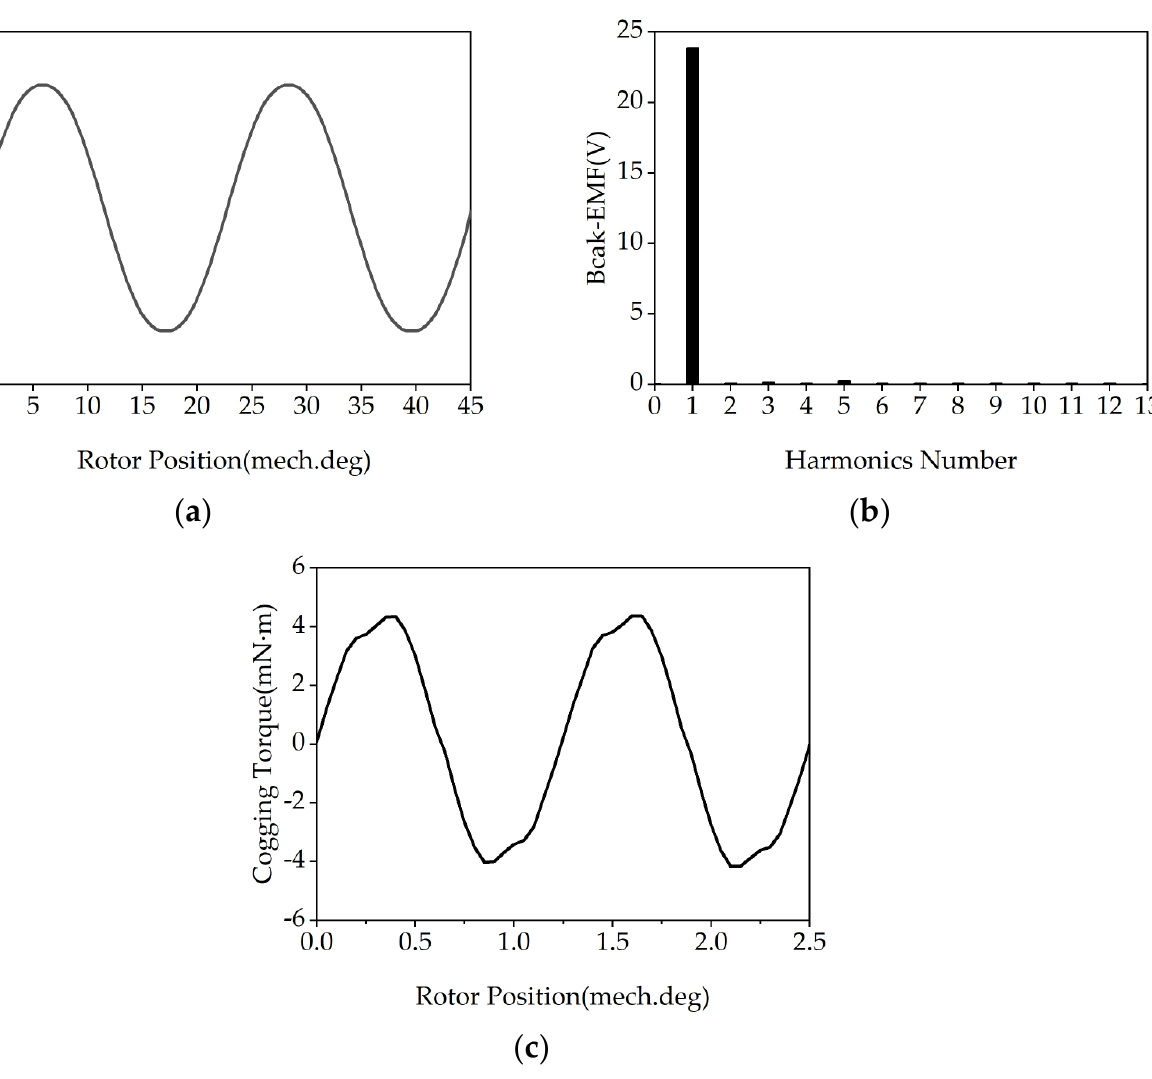
Figure 6. The no-load simulation results. ( a ) phase back-EMF; ( b ) spectra of phase back-EMF; ( c ) cogging torque.